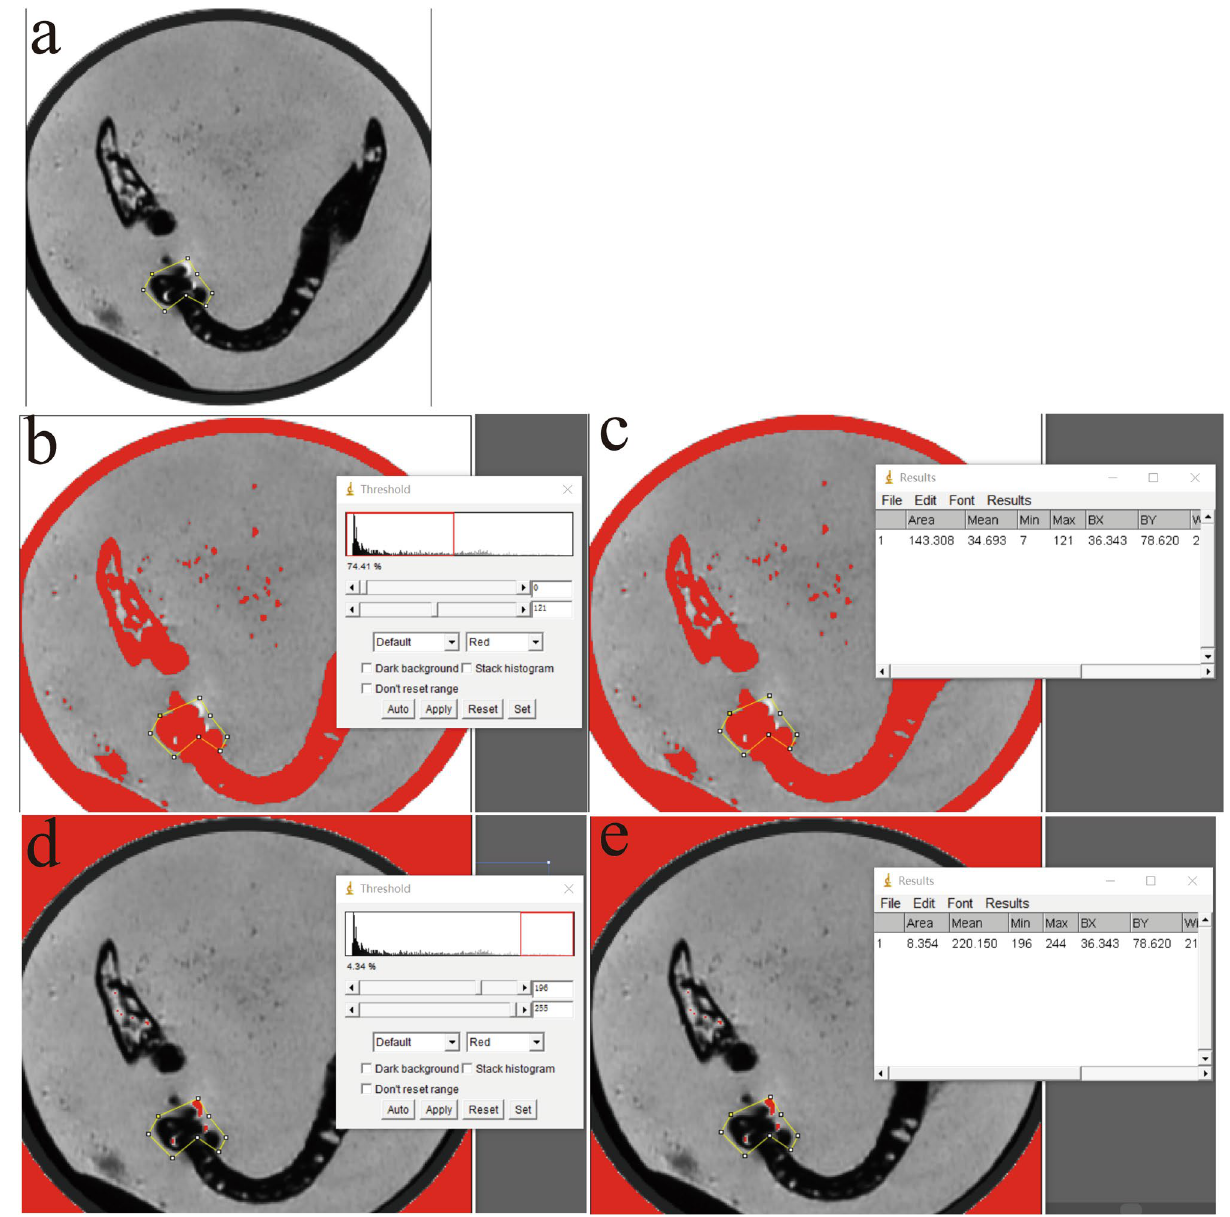
Figure 2. The artifacts areas measurement procedures. The artifacts areas measurement procedures. Selection of the ROI around the implant or the abutment in the image ( a ). Set the threshold (Image-Adjust-Threshold) ( b , d ). Measure the artifact areas of signal loss and signal intensity respectively (Analyze-Measurement) ( c , e First of all, we selected the ROI around the implant or the abutment in the image (Fig. 2a). Secondly, the thresh- old was set as the voxels within the mean signal loss intensity and three times the respective standard deviation and beyond the mean background intensity and three times the respective standard deviation (Image-Adjust- Threshold) (Fig. 2b, d). Then the areas were then measured respectively (Analyze-Measurement) (Fig. 2c, e). All of the images were measured by one professional. Each image was examined thrice, and the mean value and deviations were recorded. Twenty images selected randomly were re-measured after 20 days. Statistical analysis. Intraclass correlation coefficient (ICC) was employed to evaluate the reliability of the artifact areas of the 20 images measured in 20 days and repetition of the three scans for the same specimen. As resin was reported to induce almost no susceptibility artifacts, the resin crowns were set as control in the follow- ing analysis 26 . As for implant group, the blank group was set as control. Meanwhile, one-way ANOVA or t-test analysis was performed to compare multiple means of samples in SPSS 20.0 (Statistical Package for the Social Sciences, v22.0; IBM, Armonk, NY, USA). P < 0.05 indicated significant differences.